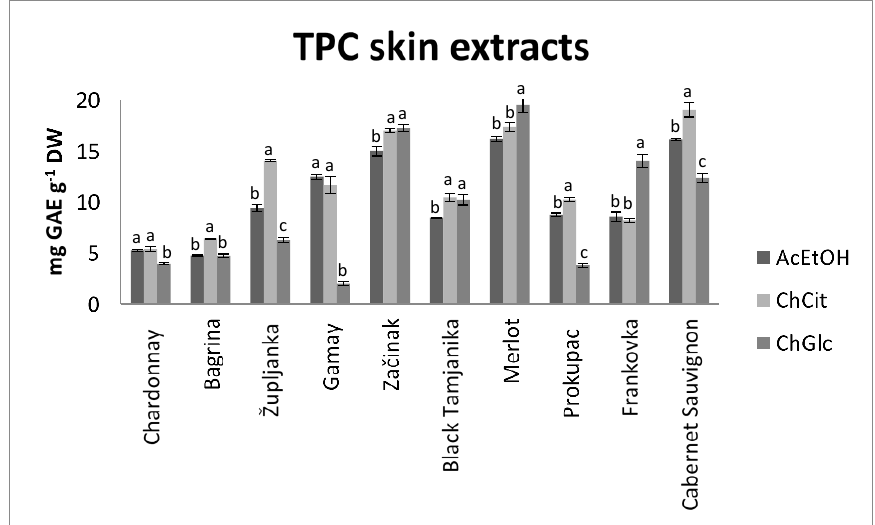
Figure 2. Total polyphenol content of skin extracts obtained from ten grape varieties. Data are expressed as mg GAE g − 1 DW for each variety, means ± SD, n = 3. Di ff erent lower case letters (a–c) indicate significant di ff erences among solvents ( p ≤ 0.05) based on post hoc Tukey’s test.